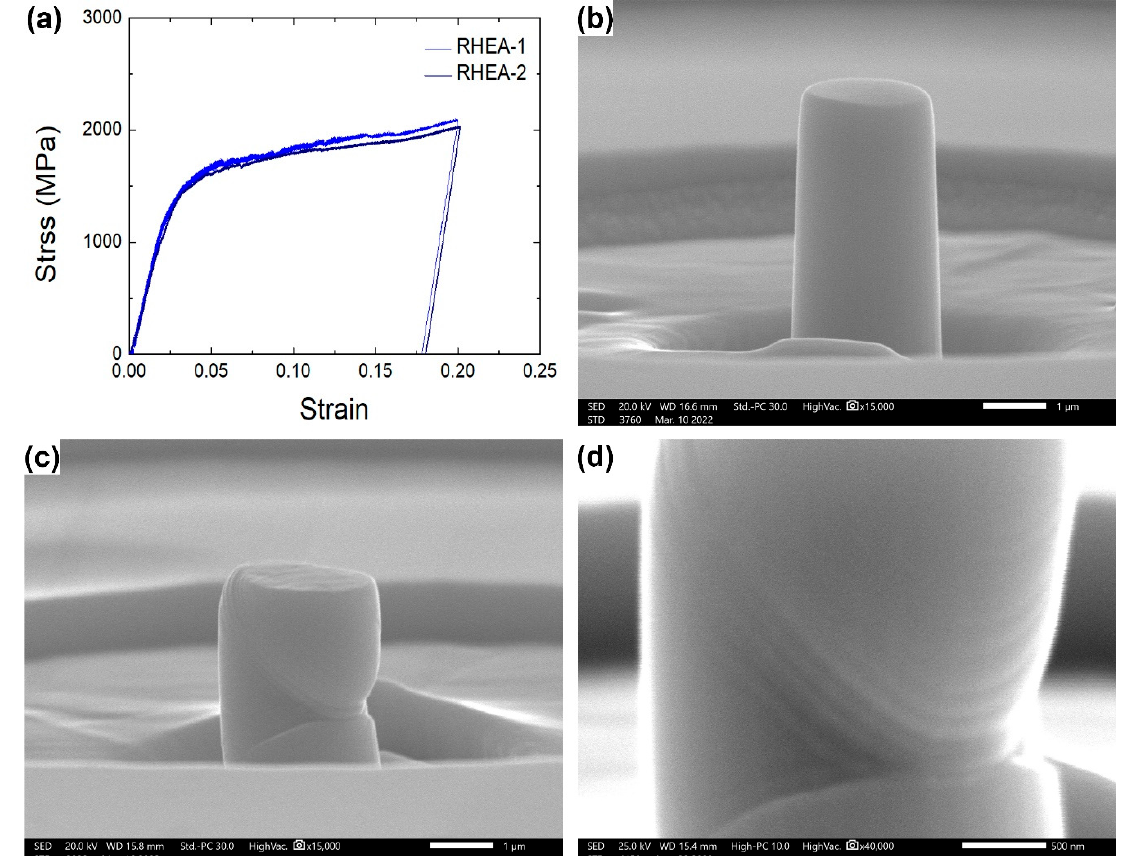
Figure 6. In situ SEM compression tests of 100 oriented single-crystalline micropillars of RHEA sample: ( a ) stress–strain curves, ( b ) SEM image of micropillar before compression, ( c , d ) SEM images of compressed micropillars.